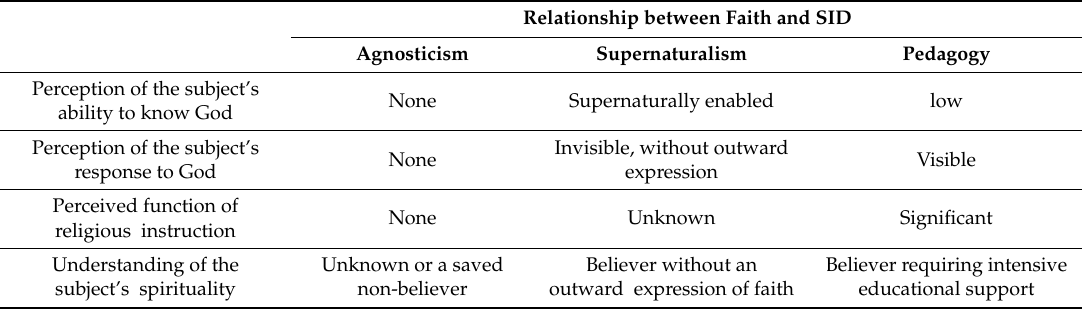
Table 1. Three conceptions of the relationship between faith and severe intellectual disabilities